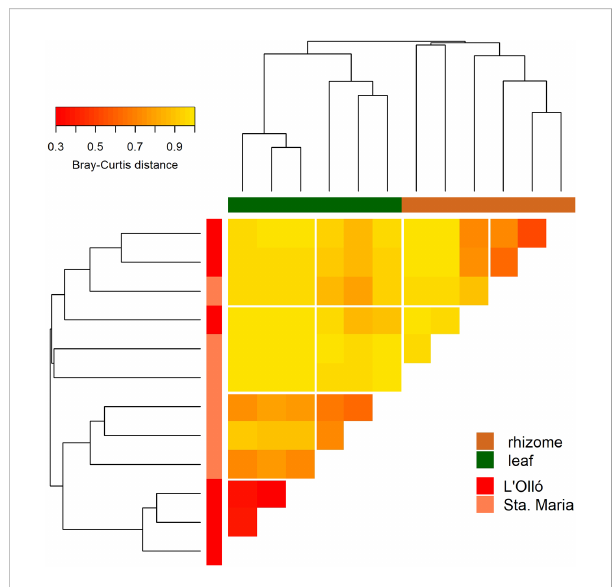
FIGURE 5 Heatmap and cluster of the Posidonia oceanica samples based on the Bray-Curtis distance. Colour codes indicate stratum (horizontal bars) or meadow (vertical bars).